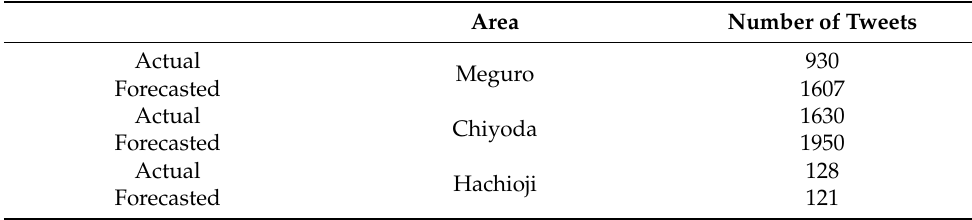
Table 5. For each municipality, number of tweets, the actual total and the forecasted total.